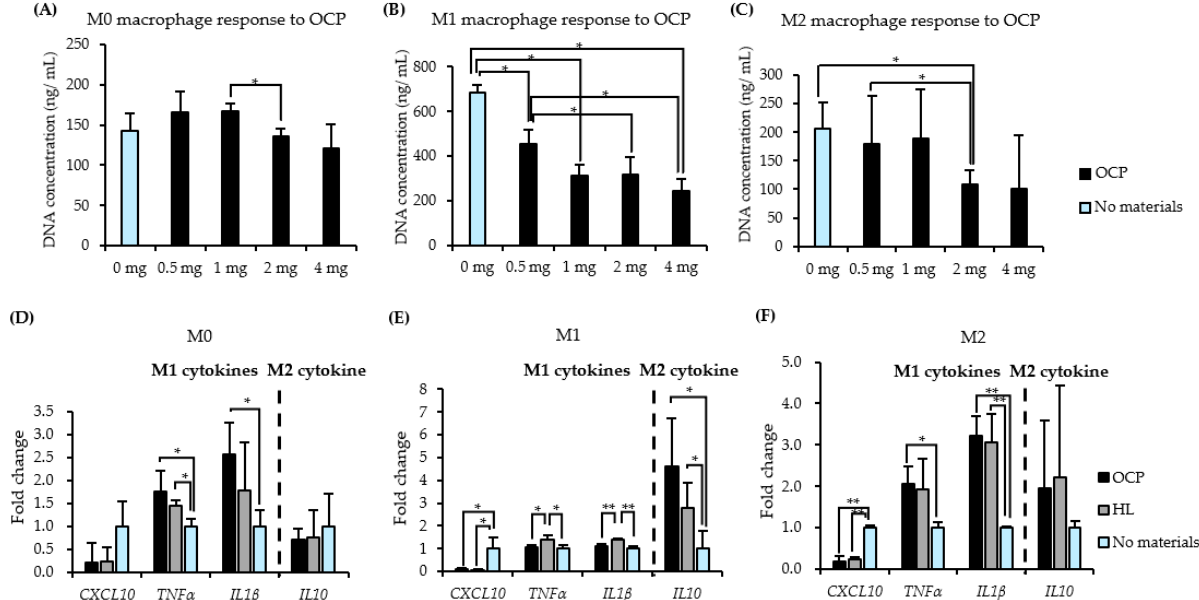
Figure 3. Responses of THP-1 derived macrophages to CaP granules. ( A – C ) DNA content of THP-1-derived M0, M1, and M2 macrophages treated with different OCP granules doses (0–4 mg). ( n = 3) ( D – F ) Expression of M1 or M2 macrophage-related cytokines on THP-1-derived M0, M1, and M2 macrophages with or without the 24 h-treatment of 0.5 mg OCP or HL granules. ( n = 3–4) ** p < 0.01, * p < 0.05.